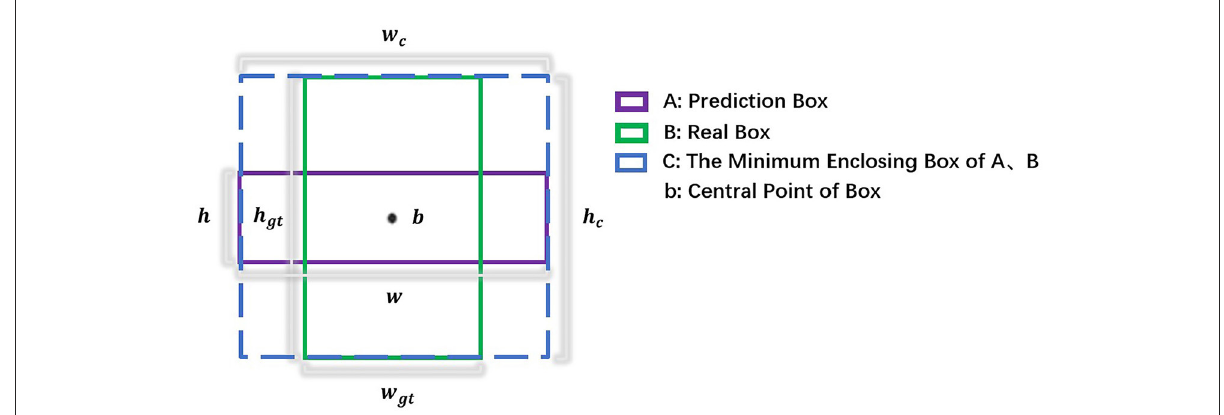
FIGURE4 The relative position of the prediction box and the real box, both of which have the same